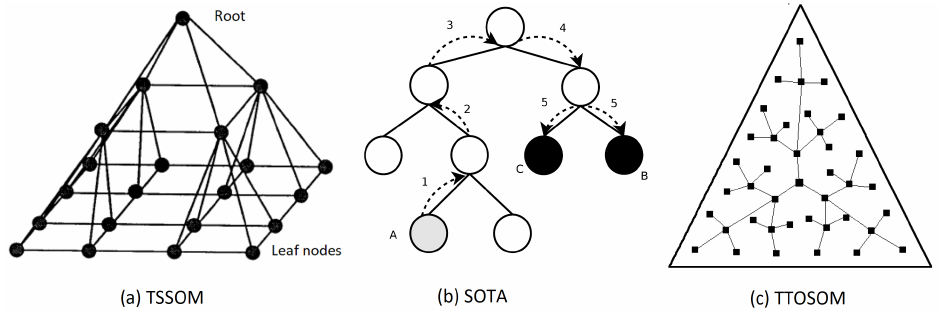
Figure 1. Examples of SOM networks organized as trees [52].